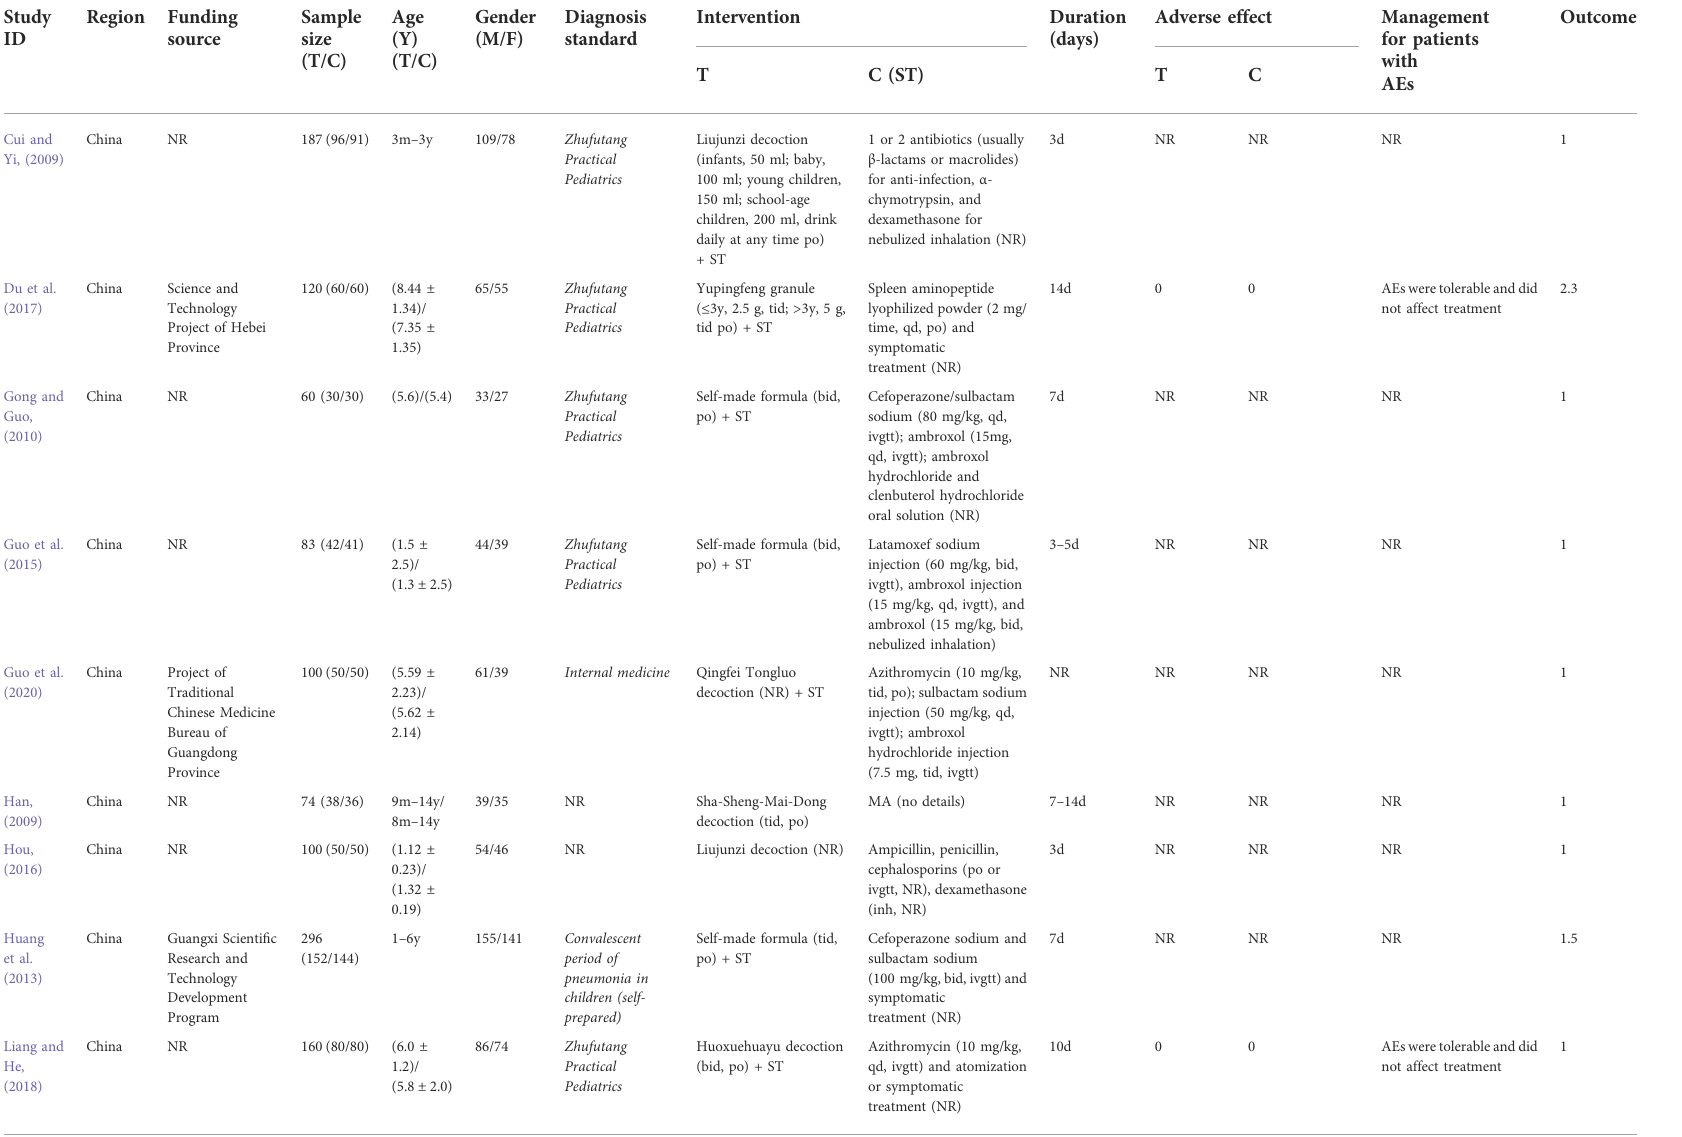
TABLE 1 Baseline characteristics of the selected studies for